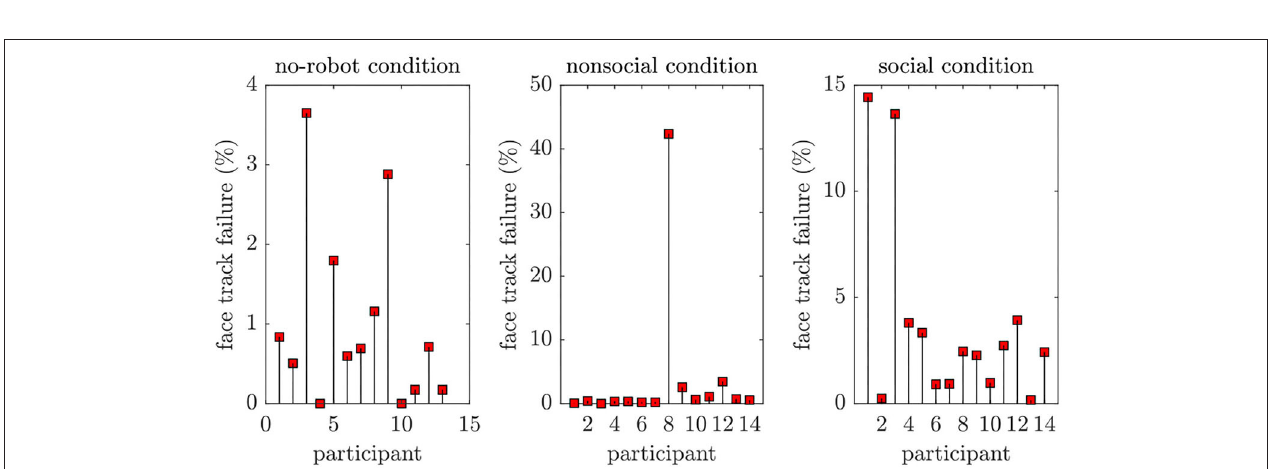
FIGURE 12 | Demonstration of tracking failures due to head movements or insufficient extrapolation of the face or loss of the face template when participants look down. Consequently, an automatized analysis and interpretation of behaviors can be misguided by those outliers.